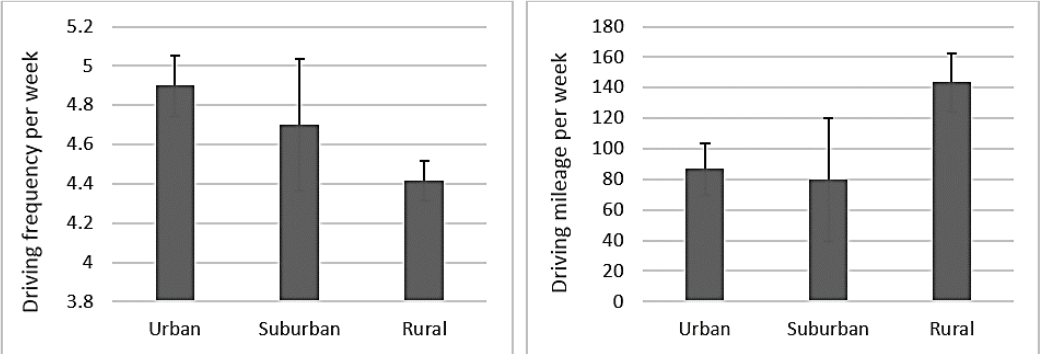
Figure 2. Reported driving frequency per week and driving mileage per week across urban, suburban, and rural participants.